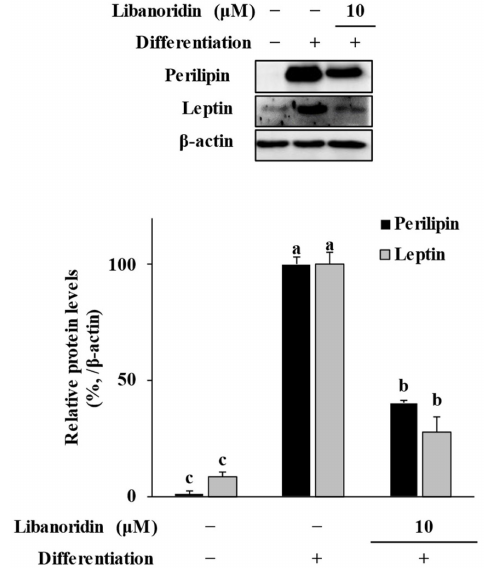
Figure 4. Effect of libanoridin on protein levels of adipogenic markers: perilipin and leptin. Protein expression levels in adipo-induced hBM-MSCs were analyzed by Western blotting at day 12 of differen- tiation. β -actin was used as an internal loading control. Values are means ± SD ( n = 3). a–c Bars with identical letters indicate no statistical significance ( p < 0.05), while different letters indicate